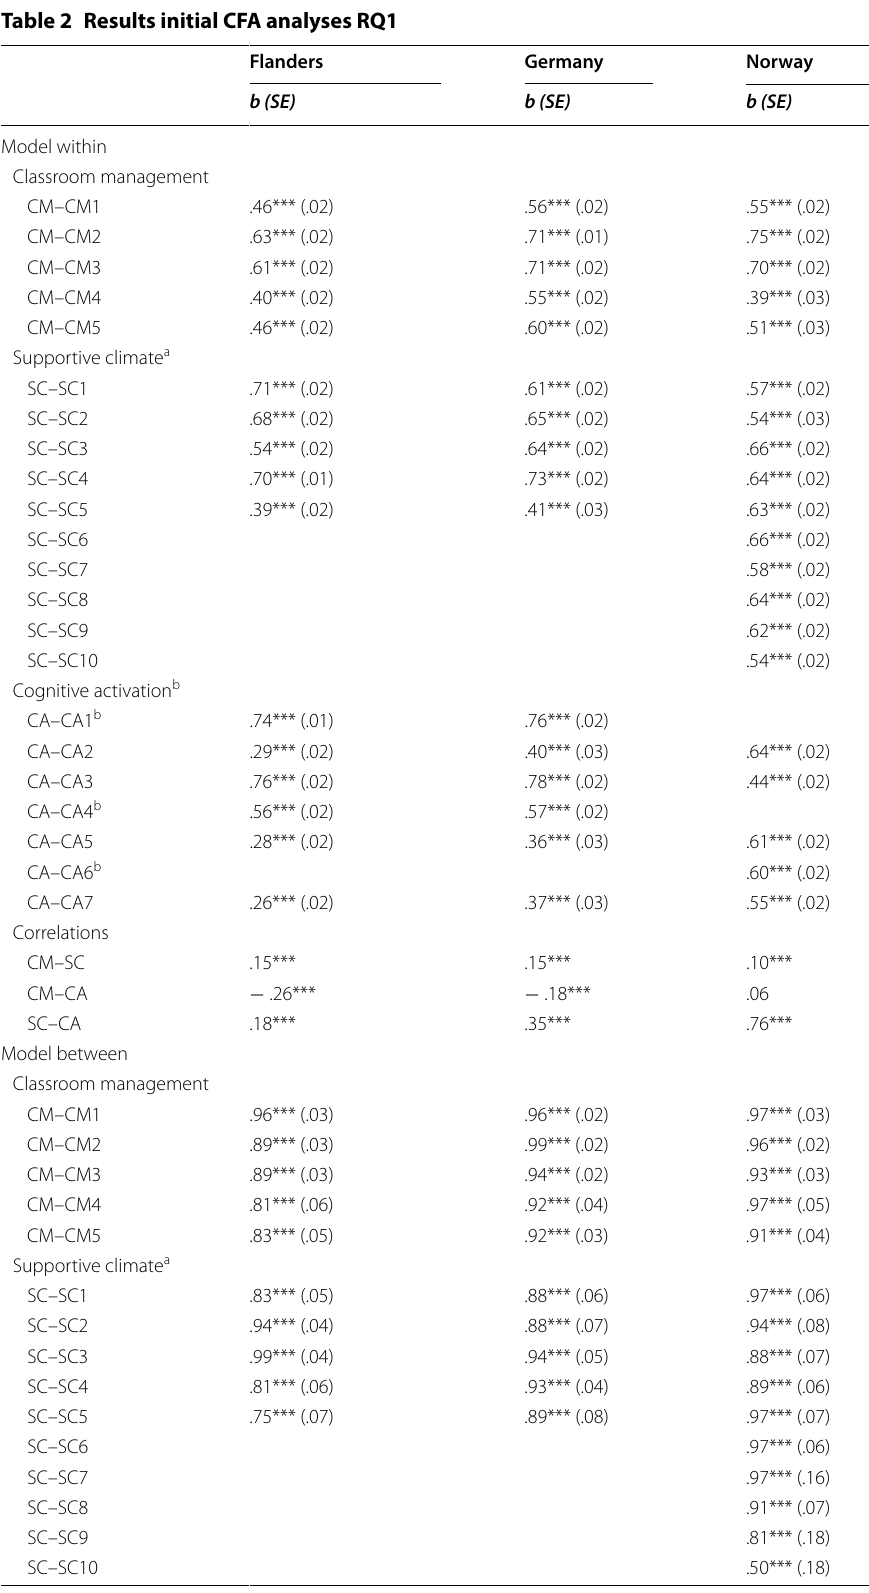
Table 2 Results initial CFA analyses RQ1 Flanders Germany Norway b (SE) b (SE) b